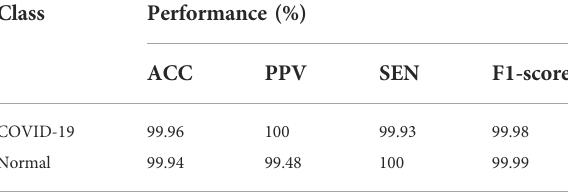
TABLE 2 Experimental results obtained by the proposed model for COVID-19 and normal cases on CT